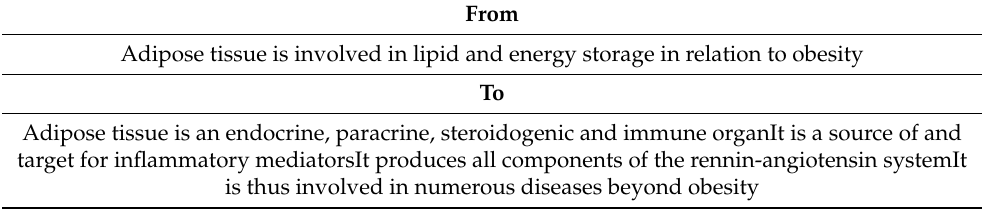
Table 2. The paradigm shifts in